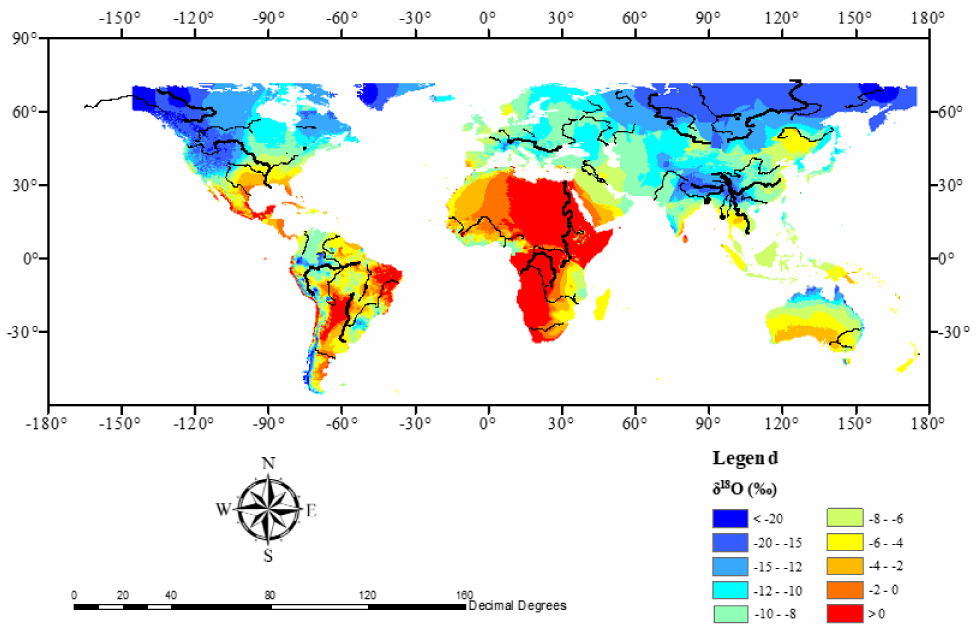
Figure 13. Global map of δ 18 O in rivers. The values are overlaid on a background generated by regression-based interpolation method. Black lines in the map are the major rivers